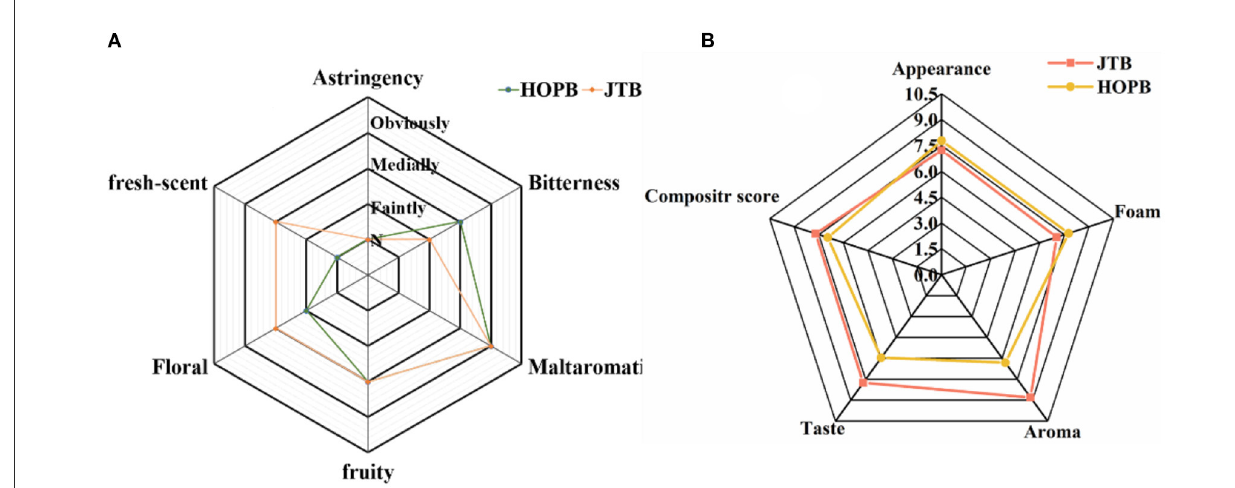
FIGURE6 Results of the sensory profiling of the beer samples. (A) Sensory evaluation of beer flavor. (B) Rating evaluation of flavor intensity of beer characteristics.